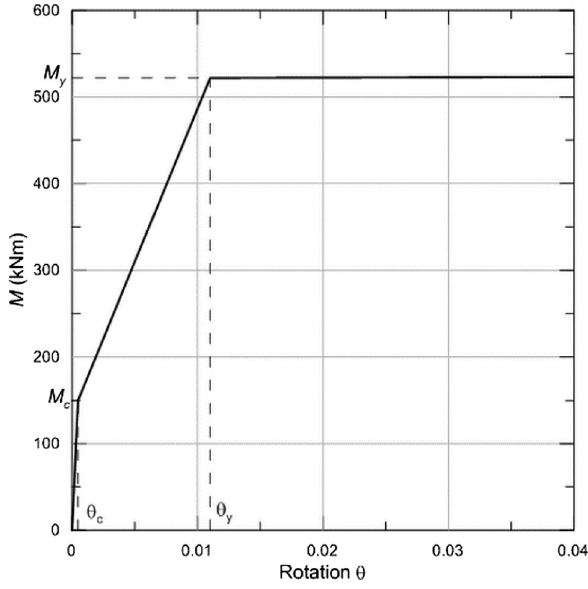
Fig. 3 Example of the moment-rotation relation for beam flexural hinges of the structural